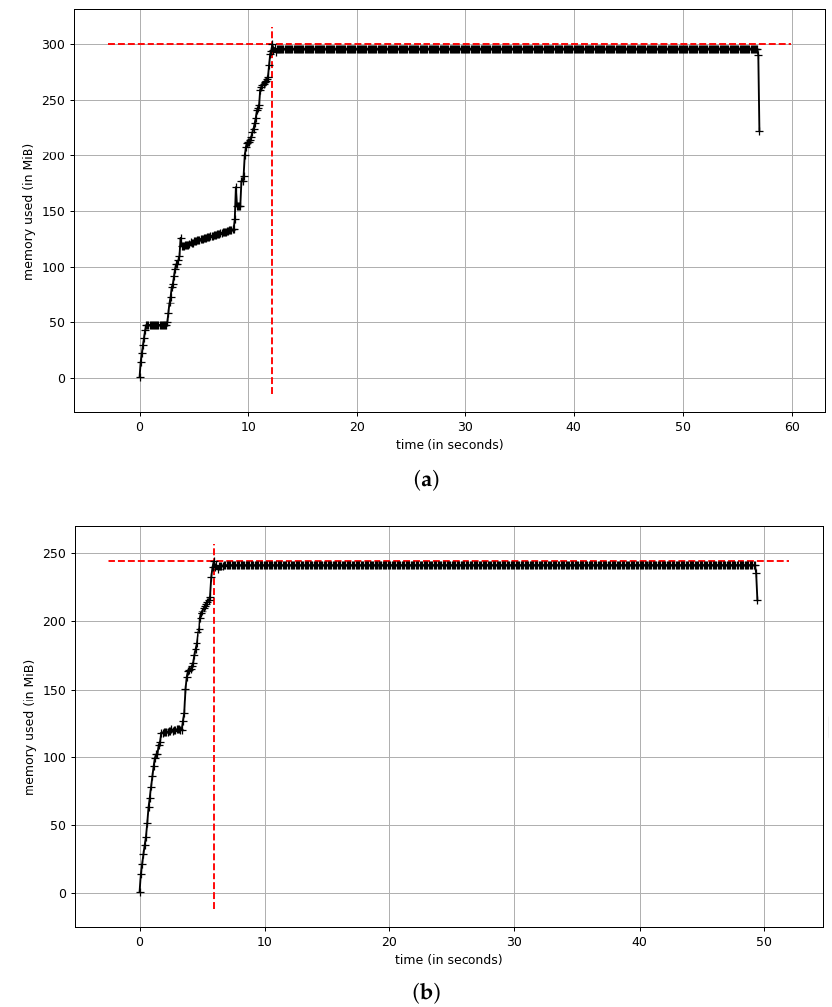
Figure 16. Memory profile of two models on NSL-KDD dataset. ( a ) Original feature dataset; ( b ) Selected feature